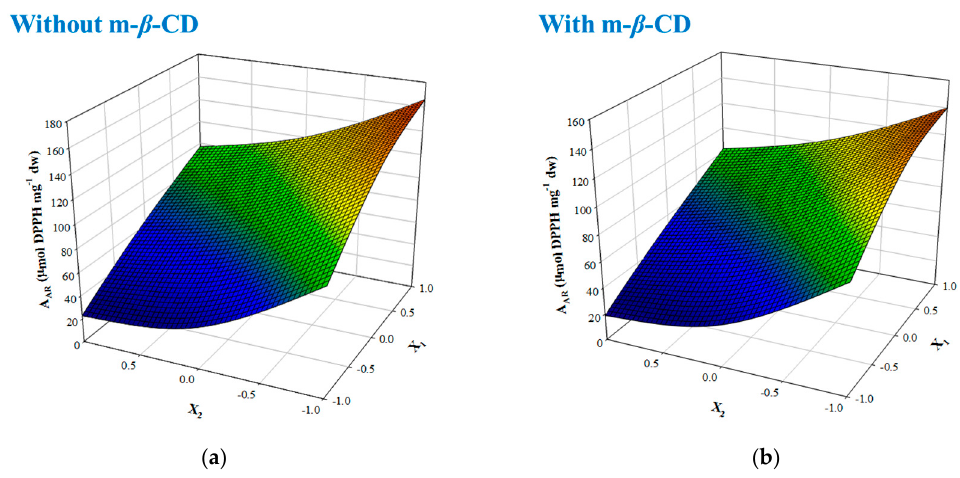
Figure 4 . 3D plots illustrating the effect of simultaneous variation of C TP and C AA on the A AR in the ( a ) absence and ( b ) presence of m- β -CD.